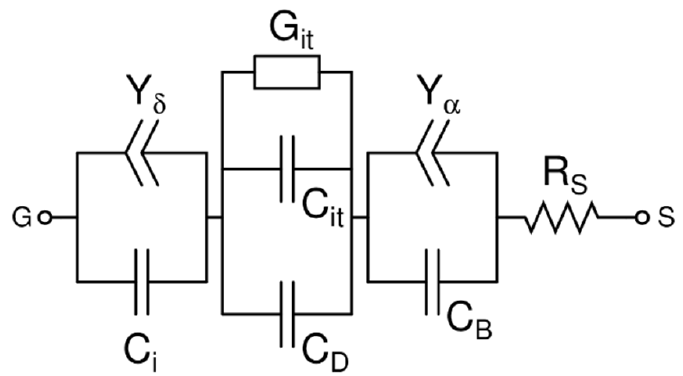
Figure 3. Organic MIS capacitor equivalent circuit.